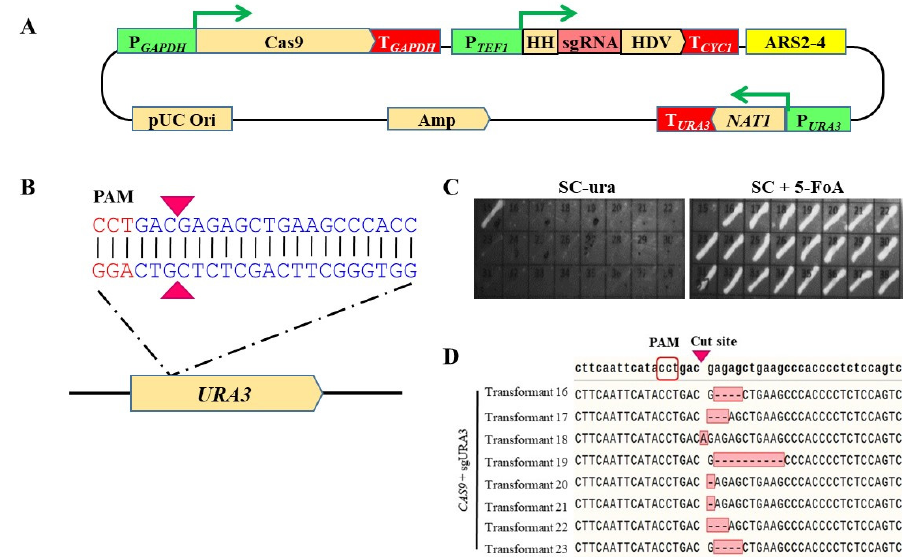
Figure 2. Targeted disruption of CaURA3 using CRISPR-Cas9 system. ( A ) Schematic diagram of pAN-Cas9gRNA vector. HH; hammerhead ribozyme, HDV; and hepatitis delta virus ribozyme. ( B ) CaURA3 target sequence generated by ATUM program. Arrowheads indicate Cas9 cleavage site. ( C ) Conformation of ura3 mutant phenotype on SC-ura and SC + 5-FOA plates. ( D ) Sequence analysis of CaURA3 from eight transformants. Insertions or deletions were indicated (red box).